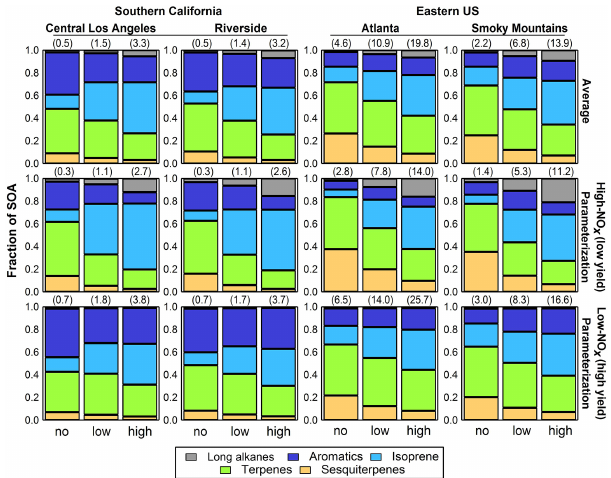
Figure 4. Bar charts showing the fractional contribution from the various VOC precursor classes to the total simulated SOA for two locations in SoCAB (central Los Angeles and Riverside) and two in the eastern US (Atlanta and the Smoky Mountains). Results are shown for (top) average, (middle) high-NO x , low-yield and (bottom) low-NO x , high-yield simulations. Each panel shows re- sults from the 14-day average (left-to-right) SOM-no, SOM-low and SOM-high simulations. The average SOA concentration (in µgm − 3 ) is for each location and simulation is given in parenthe- ses above each